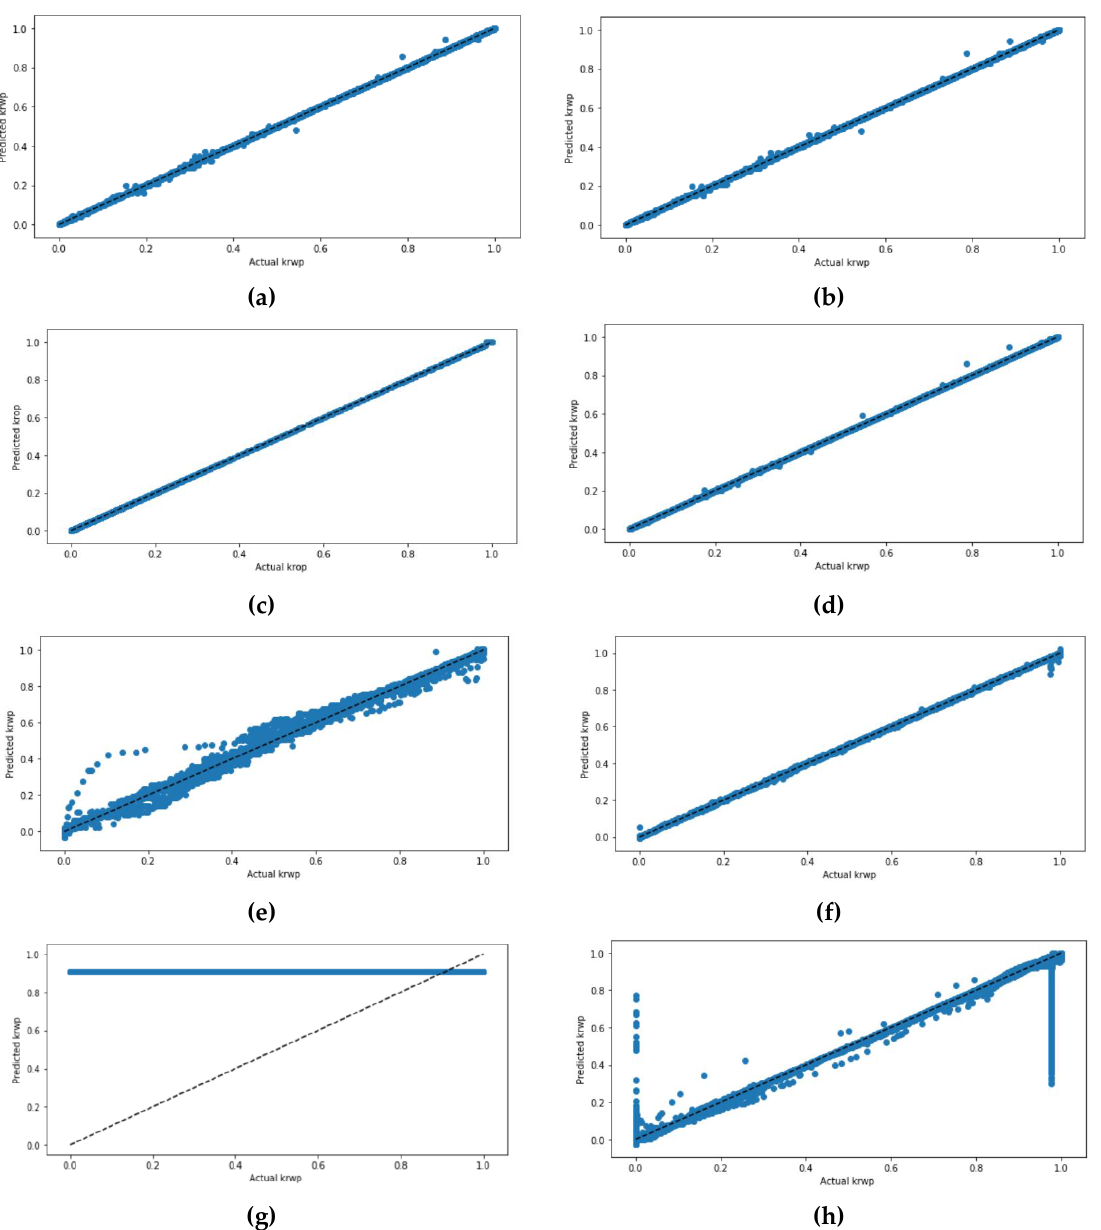
Figure 13. Actual vs. predicted k rwp using different machine learning techniques DT, RF, GBR, and ANN. ( a ) DT without scaling, ( b ) DT with scaling, ( c ) RF without scaling, ( d ) RF with scaling, ( e ) GBR without scaling, ( g ) GBR with scaling, ( f ) ANN without scaling with tanh, ( h ) ANN scaling with tanh. The dashed line represents a full coinciding between actual and predicted